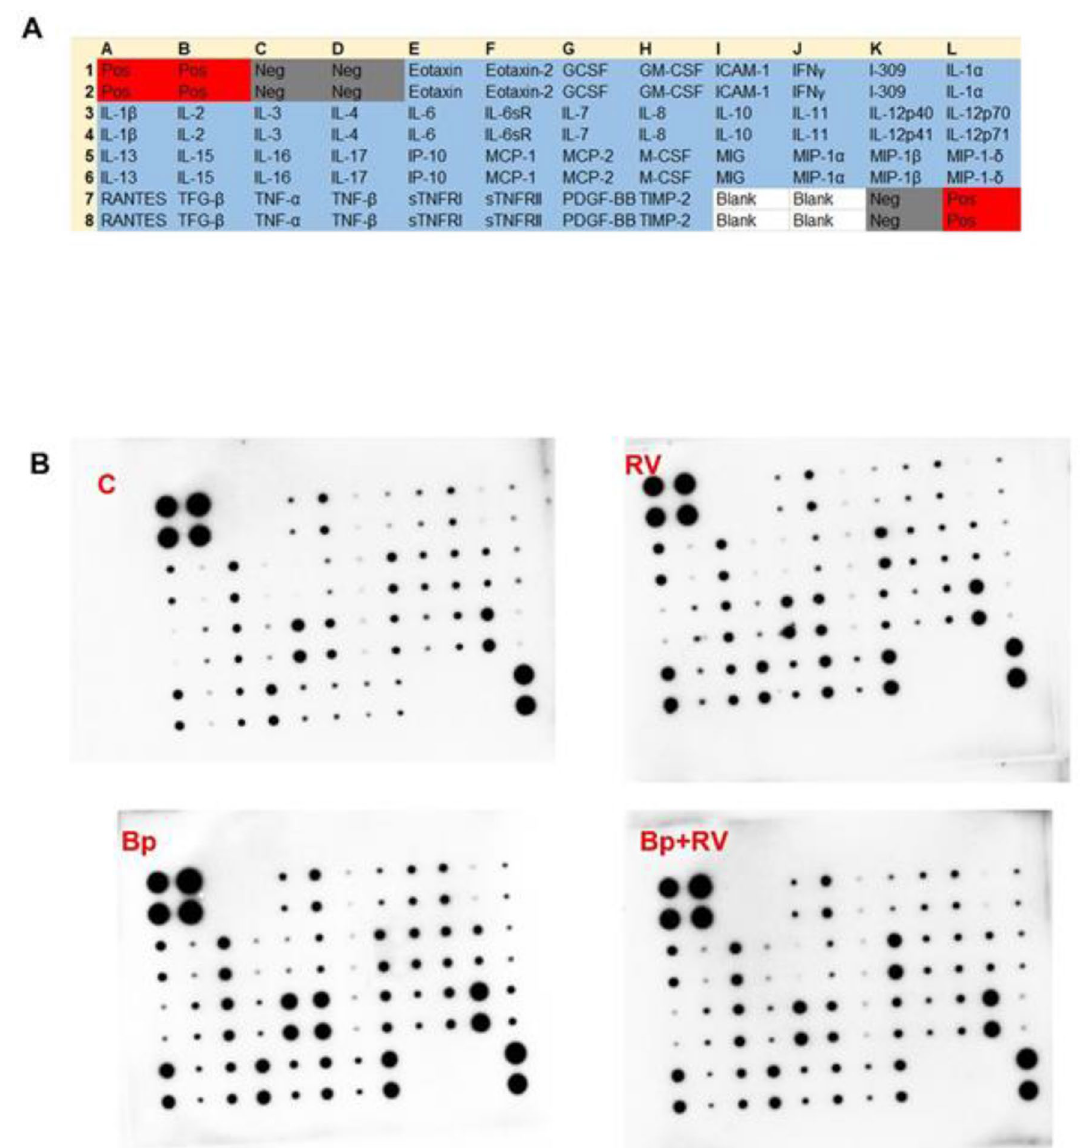
Figure 1. Inflammatory pattern by antibody array. ( A ) Layout of the antibodies as spotted on the membrane. The abbreviated names for 40 different cytokine probes are reported. ( B ) Representative photographs of cytokine arrays in which each cytokine is represented by duplicate spots on a single